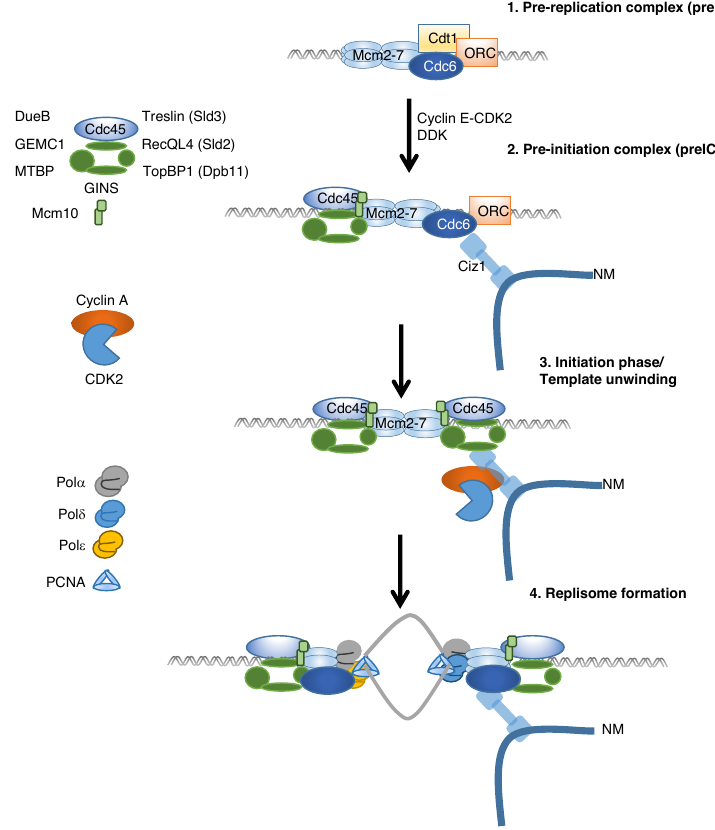
Figure 1. Replication complex assembly from origin specification to replisome